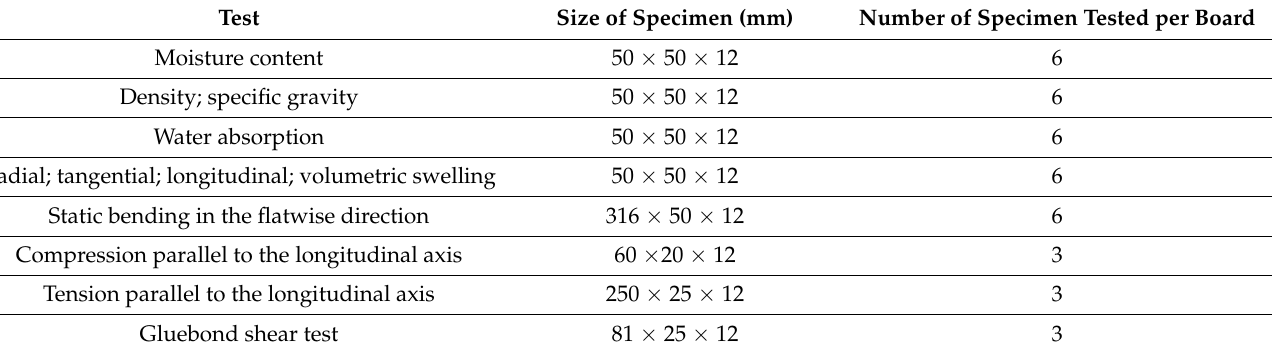
Figure 1. Fabrication of seven-ply rubberwood LVL; ( a ) veneer size: 400 × 400 × 2 mm ( b ) ratio of PF to filler is 3:1; ( c ) PF and filler were mixed thoroughly; ( d ) ready-use resin; ( e ) resin application on the veneer; ( f ) LVL lay-up with veneer tight side facing tight side and loose side facing loose side; ( g ) cold pressing for five minutes; and ( h ) hot pressing for twelve minutes. Table 2. Cutting size of specimens for physical and mechanical tests.